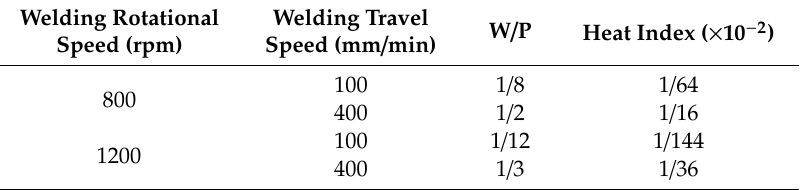
Table 4. E ff ect of welding travel speed on weld pitch (W / P) and heat index. Table 4. Effect of welding travel speed on weld pitch (W/P) and heat index. Welding Rotational Welding Rotational